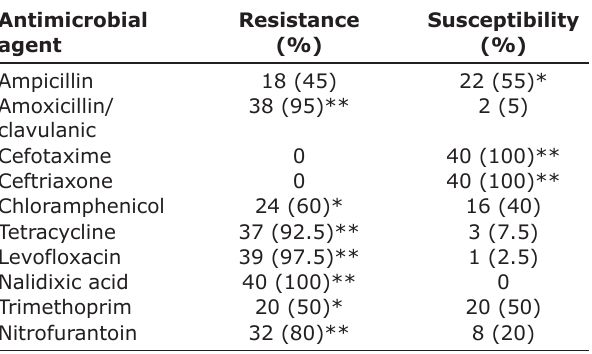
Table-3: Antibiogram of NTS strains collected from broiler farms by disk diffusion method. Antimicrobial agent